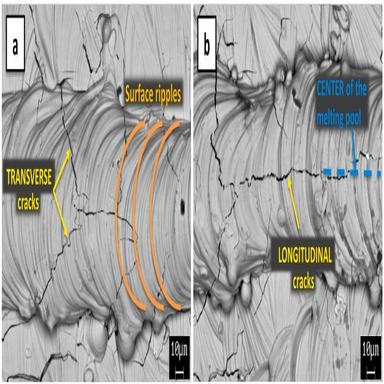
SEM images of two SSTs: shape and orientation of transverse cracks (a), and longitudinal cracks (b).